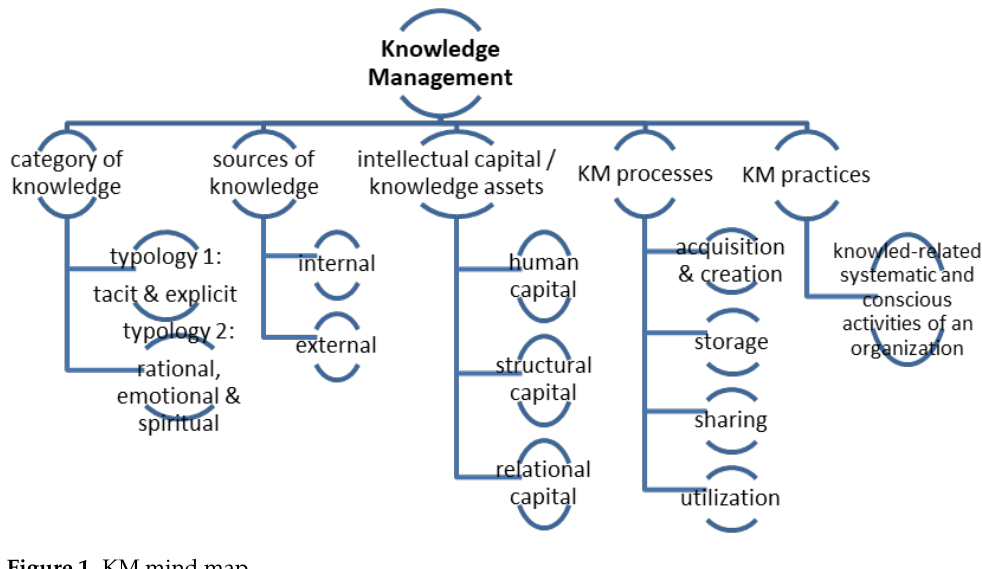
Figure 1. KM mind